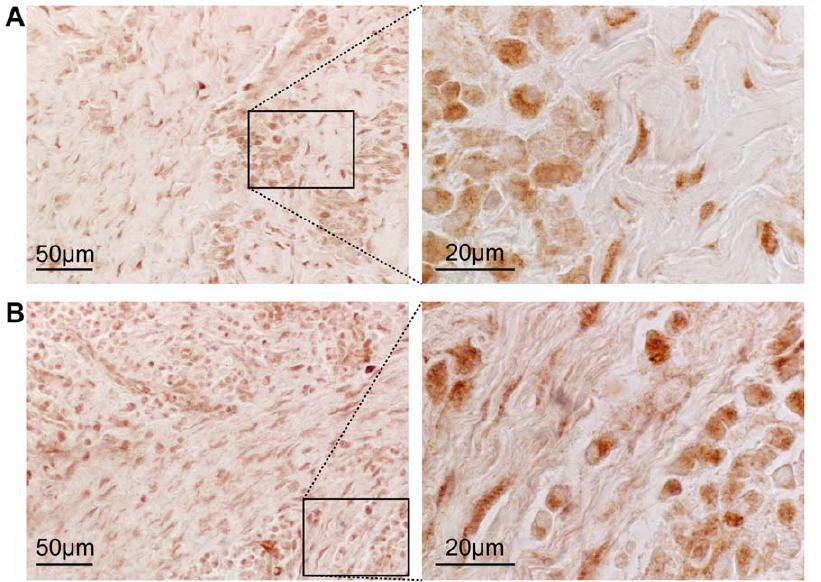
Figure 7. Immunohistochemical stainings of IRF4 and CCL18 in the connective tissue of periodontitis-affected gingival sections. A. Immunohistochemical staining of IRF4. B. Immunohistochemical staining of CCL18.